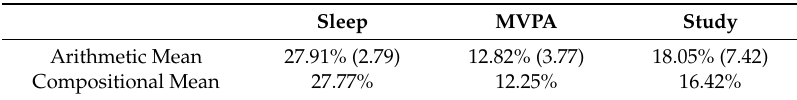
Table 2. Standard and compositional descriptive measures of the proportions of time spent in sleep, MVPA, and studying: arithmetic mean (standard deviation in parentheses) and compositional mean. Results expressed in percentage of 24 h.